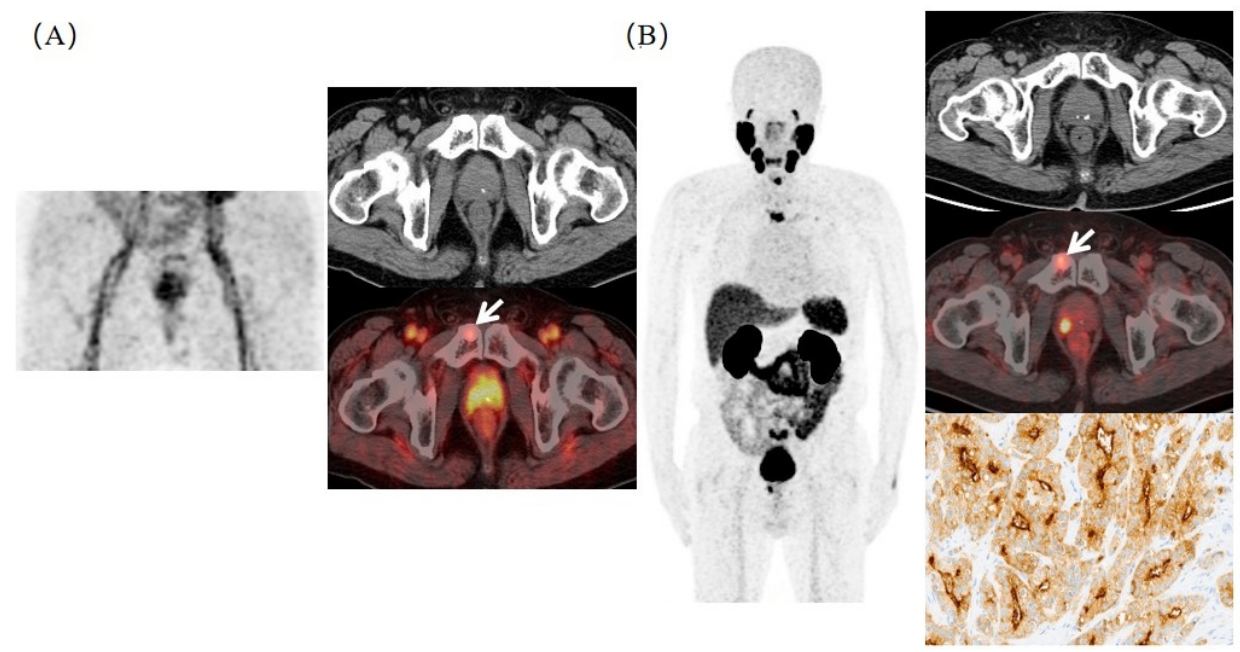
Figure 5. Typical 68 Ga-PSMA-11 PET/CT images in detecting osseous metastasis. ( A ) The right pubic bone metastasis (white arrow) was visible at 3 min P.I. (SUV max = 5.1). ( B ) Corresponding bone metastasis (white arrow) also displayed at 45 min P.I. (SUV max = 8.2), which was confirmed in pathological results.